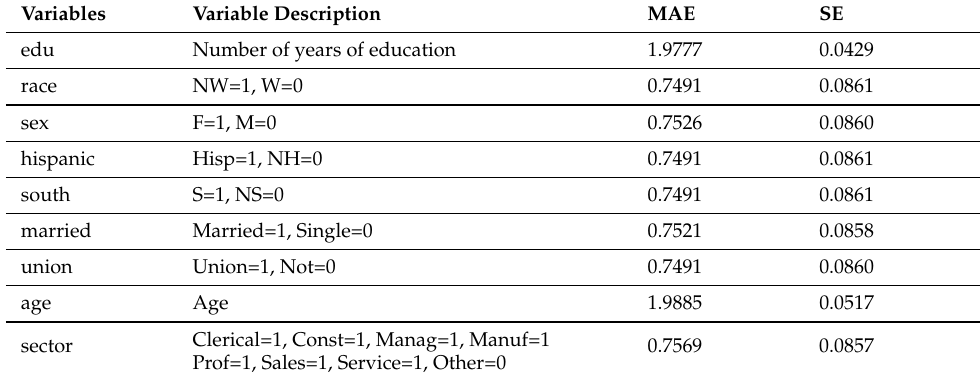
Table 2. The MAE and SE of predictions of workers’